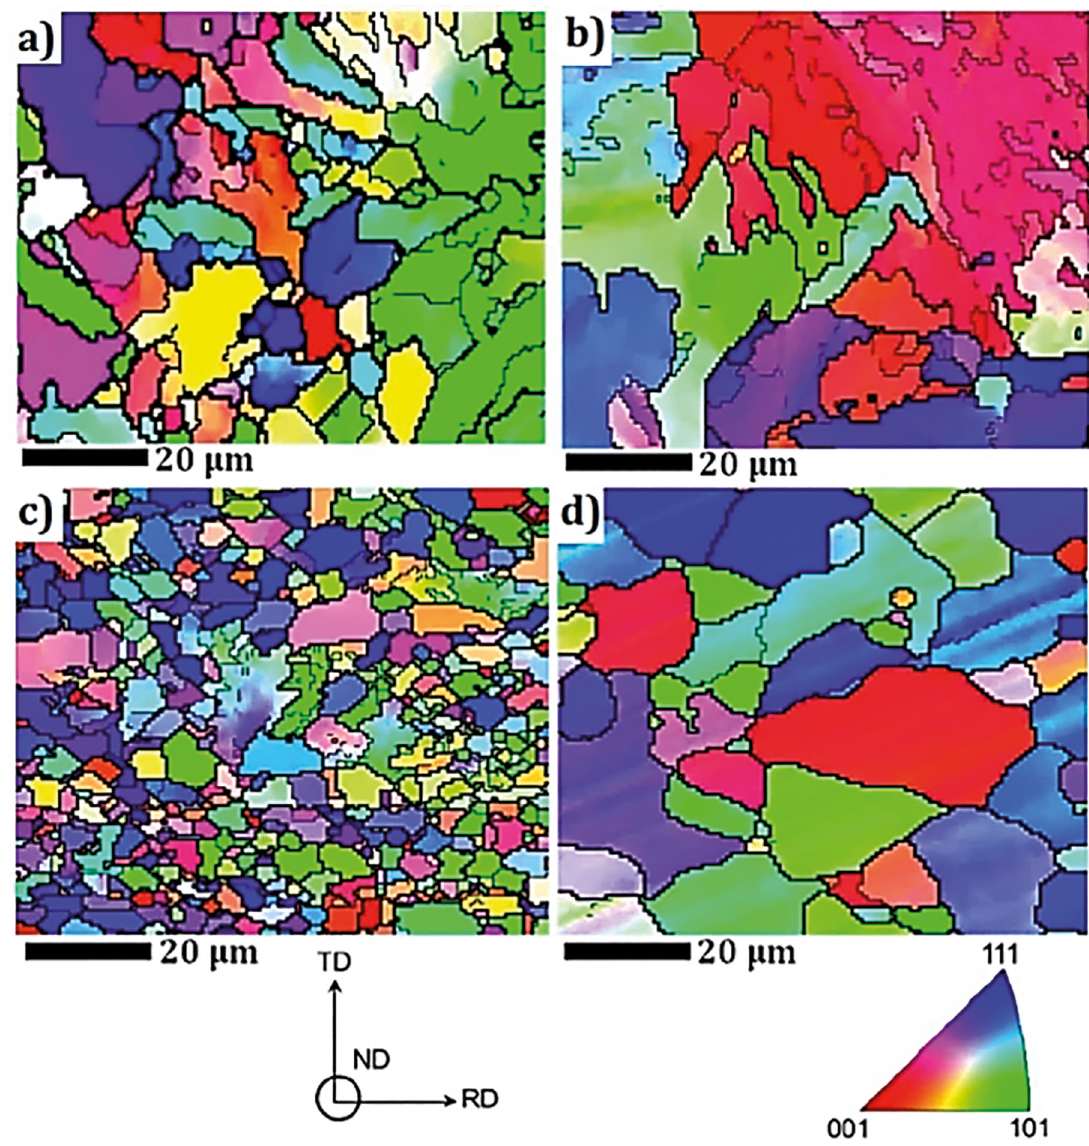
Figure 5: IPF maps of (a) AC, (b) ACN, (c) WQ350 and (d) WQ700 samples.